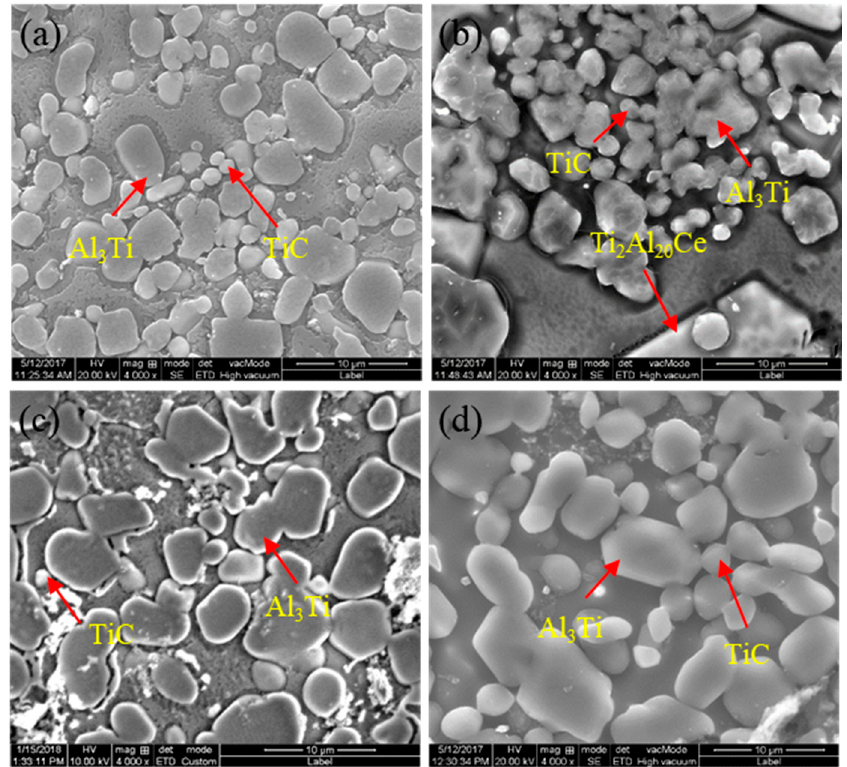
Figure 6. SEM images of the quenching samples of prefabricated block with different CeO 2 size under complete reaction: ( a ) 30 nm; ( b ) 50 nm; ( c ) 1 μ m and ( d ) 2–4 μ m.